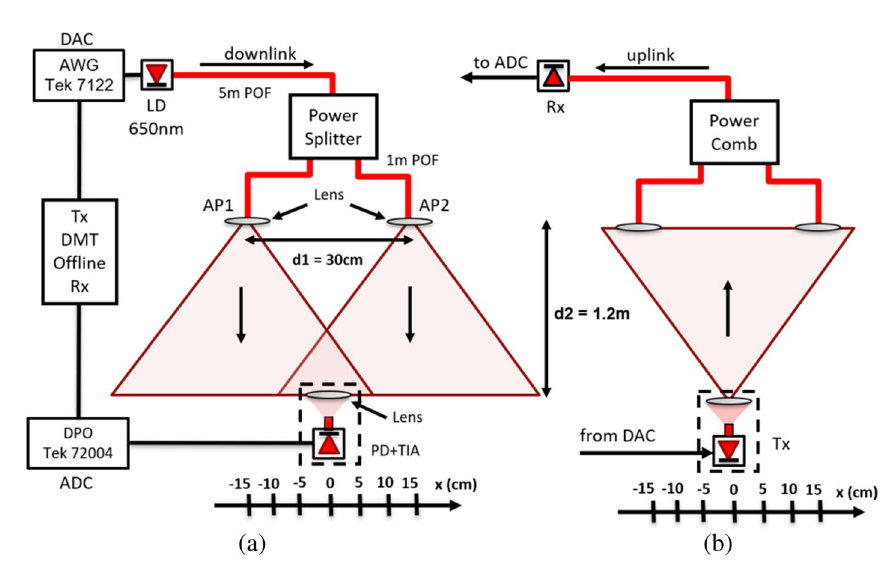
Fig. 17 Passive DUs: schematic, where the red path refers to a optical downlink, b